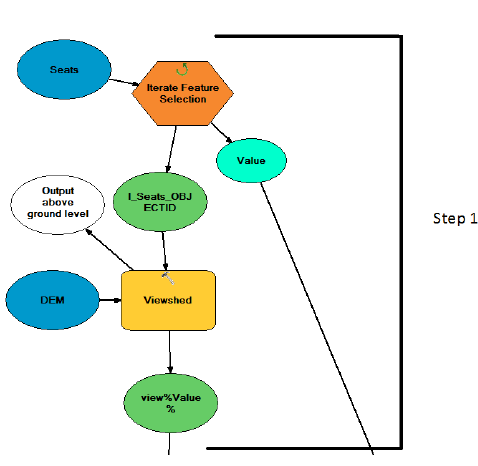
Figure 2: Step 1: Viewshed